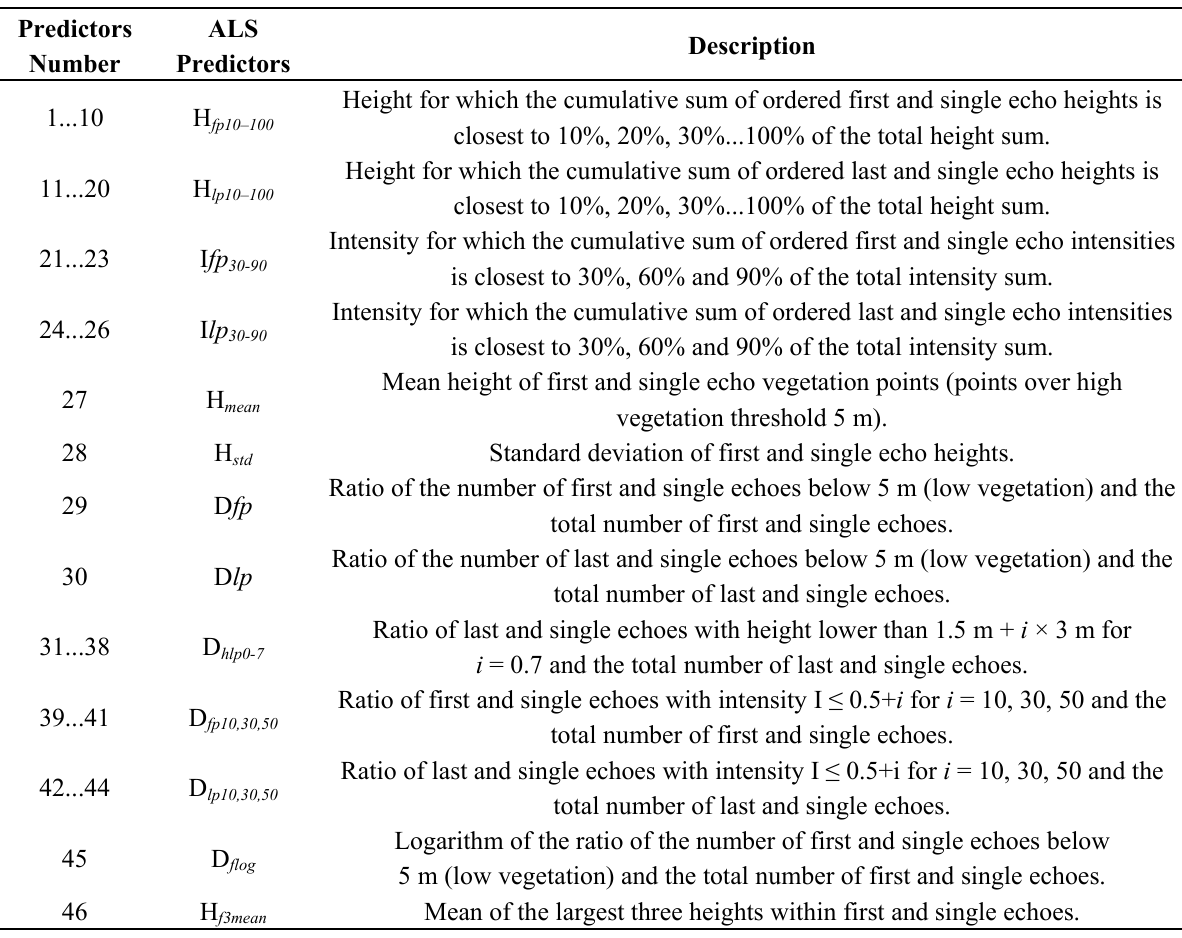
Table 3. List of airborne laser scanning (ALS) explanatory